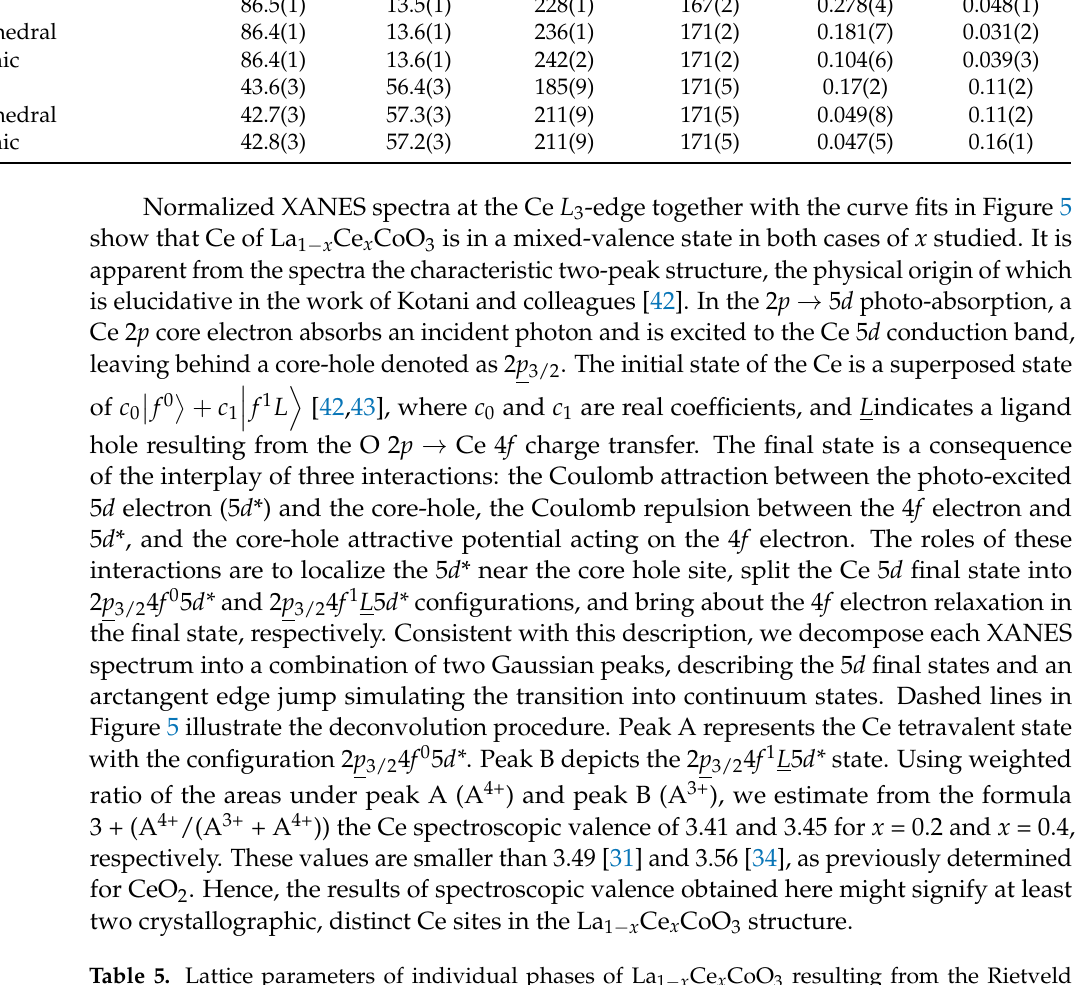
Table 5. Lattice parameters of individual phases of La 1 − x Ce x CoO 3 resulting from the Rietveld refinement. Form of dopants: Ce 4+ /Co 2+ . Numbers in parentheses are statistical errors of the last significant